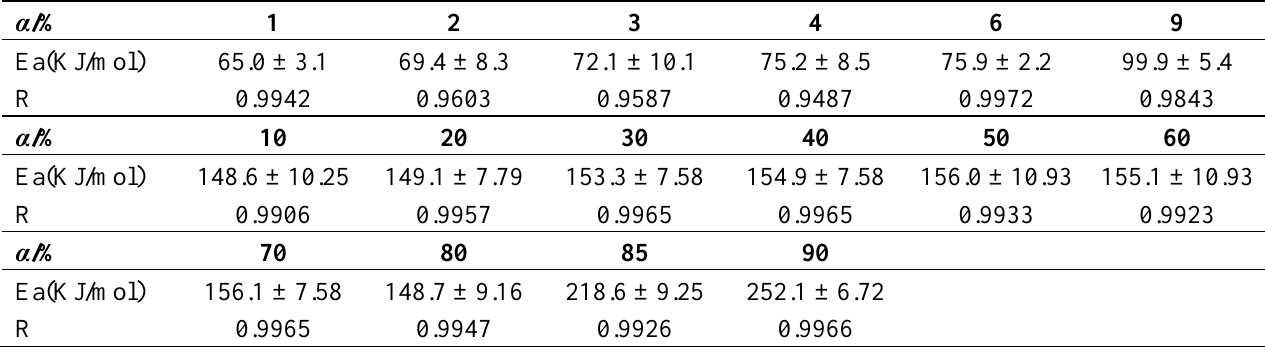
Table 2. Activation energies obtained using the Ozawa